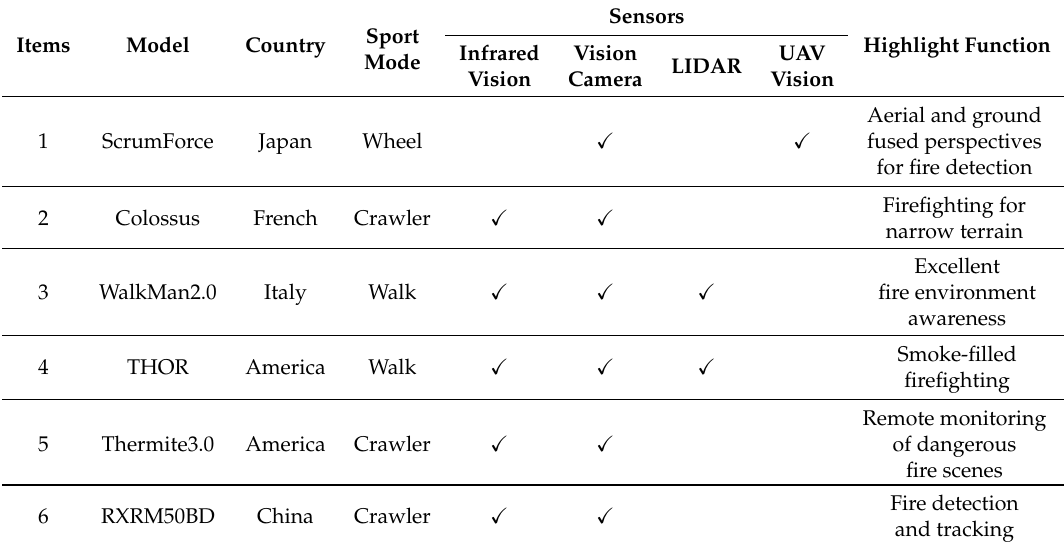
Table 1. The functional characteristics of several current mainstream fire robots in the